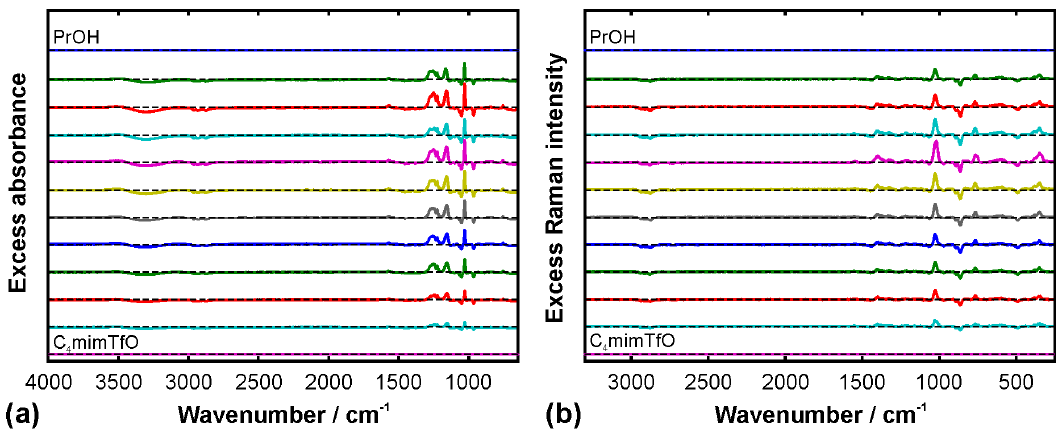
Figure 3. Excess ATR-FTIR spectra ( a ) and excess Raman spectra ( b ) of the neat substances and the binary mixtures.